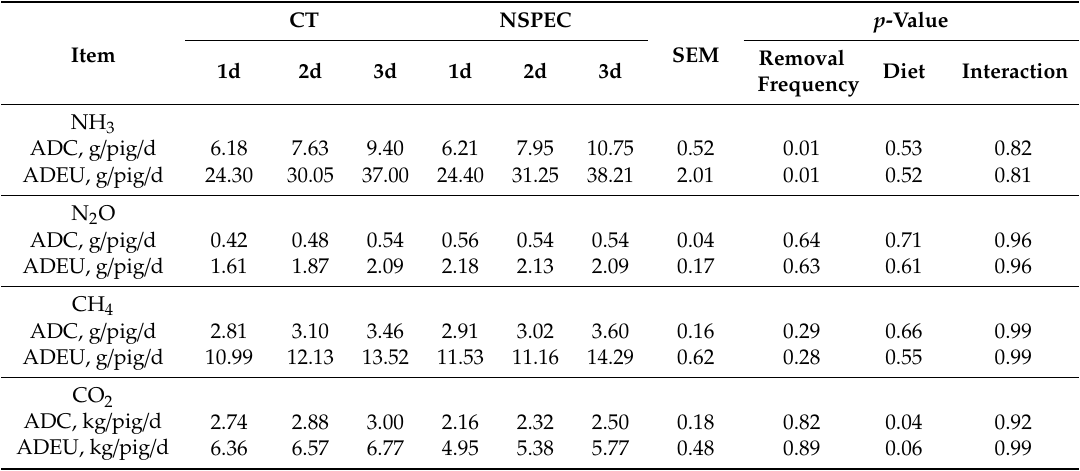
Table 3. The NH 3 , N 2 O, CH 4 and CO 2 emissions from pigs fed a CT diet or diet containing NSPEC with di ff erent manure removal frequencies 1